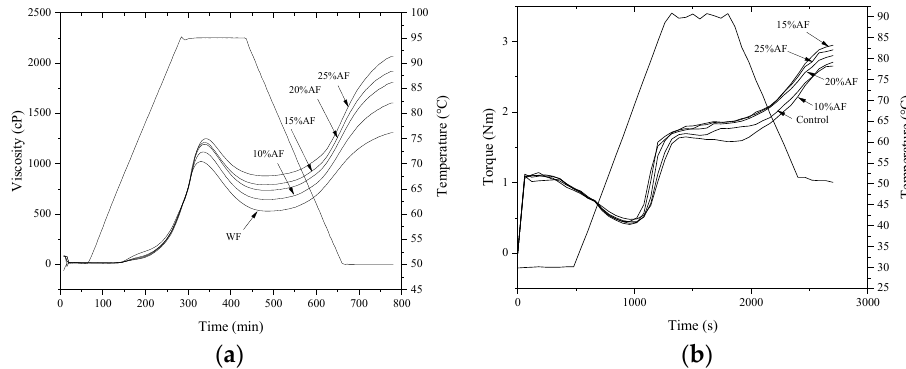
Figure 1. Pasting ( a ) and mixing ( b ) profiles of mixed flour with different substitution